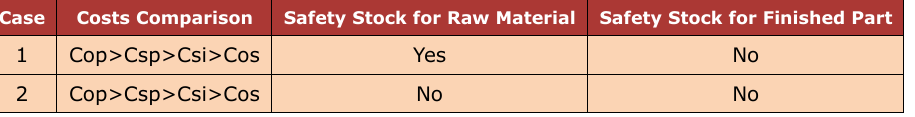
Table 2. Cost comparison and safety stock